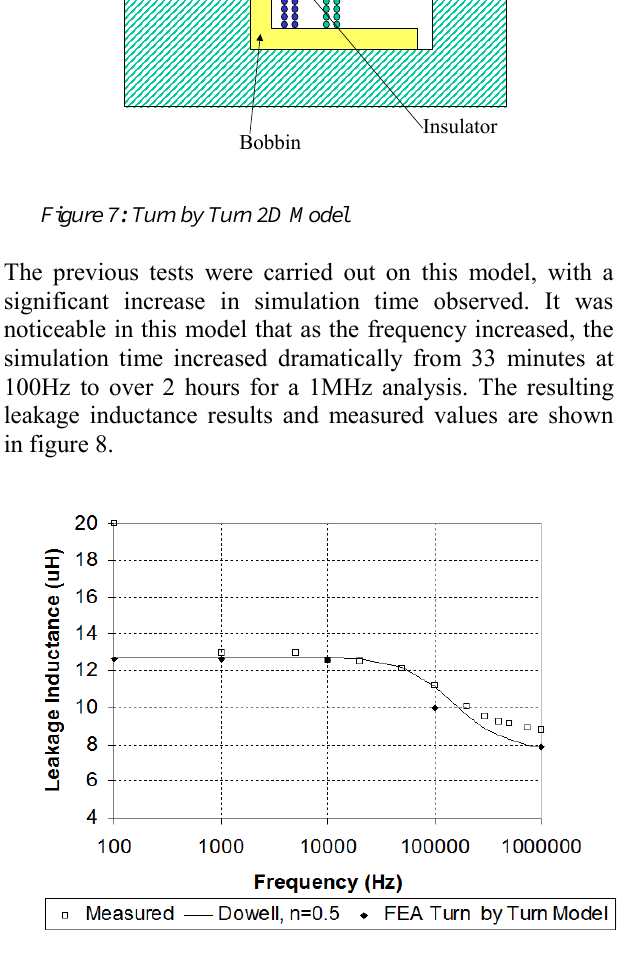
Figure 8: Turn by Turn 2D Finite Element